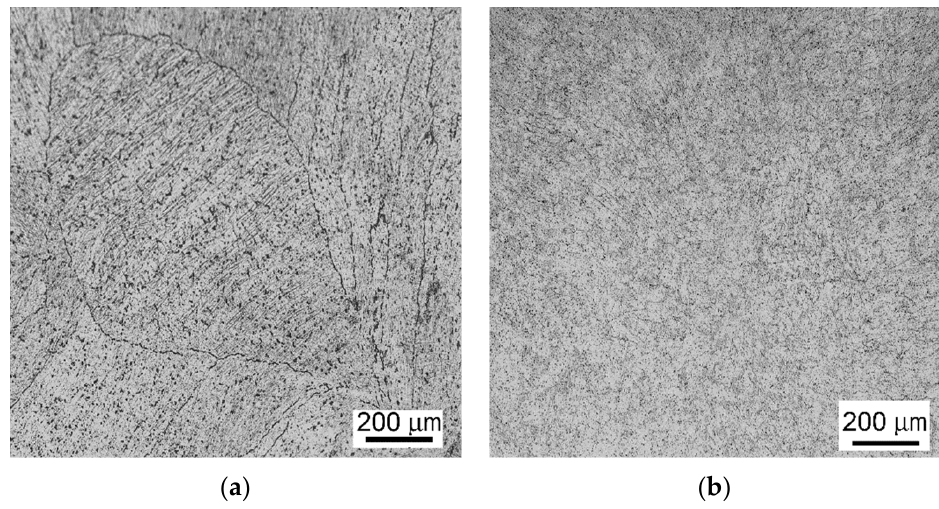
Figure 6. Structures of NiTi samples: sample 5a—as-cast, prepared by VIM ( a ); sample 5b—as-cast and rotary swaged ( b ).